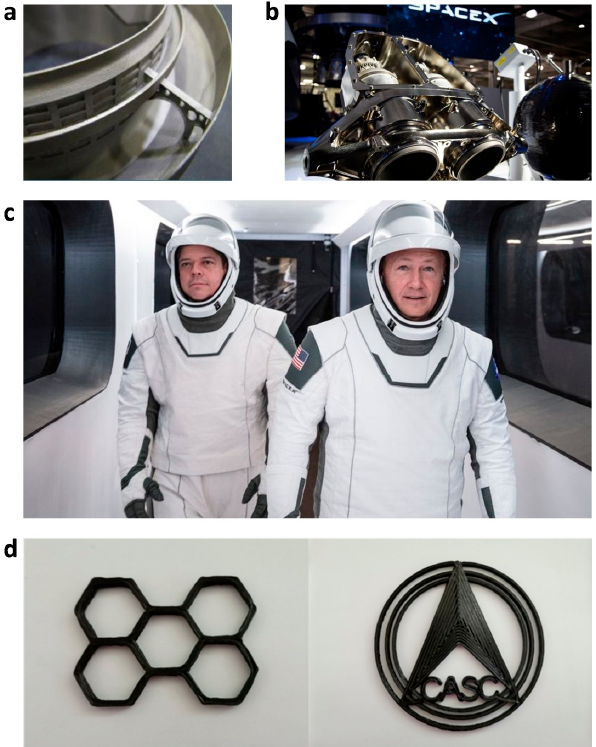
Figure 15. ( a ) The flex joint of the RS ‐ 25 [164], ( b ) SpaceX’s SuperDraco engine [165], ( c ) astronauts Bob Behnken and Doug Hurley wearing SpaceX spacesuits [165], and ( d ) two samples of continuous